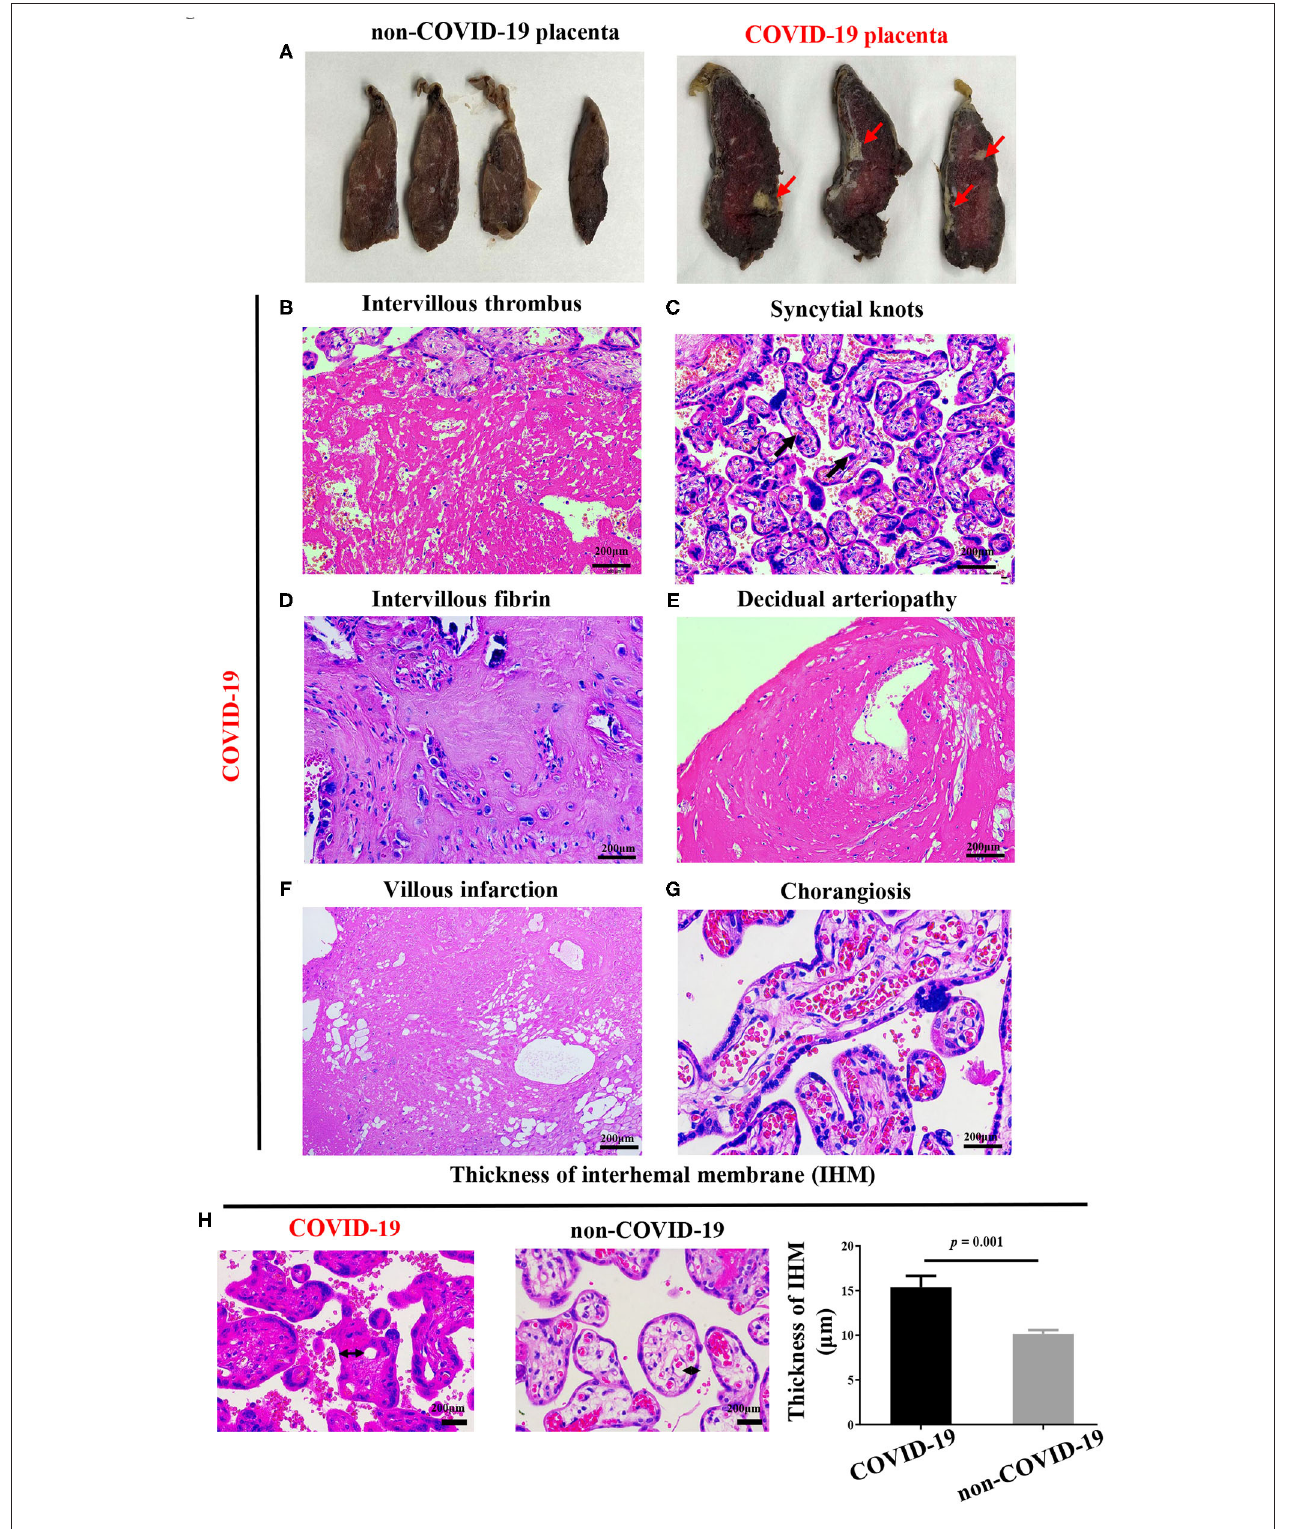
FIGURE 3 | Pathological changes of COVID-19 placentas. (A) Sagittal plane of COVID-19 placentas showing hypoxia and infarction, (B–H) H&E stains of COVID-19 placentas showing (B) intervillous thrombus (C) syncytial knots and (D) intervillous fibrin, (E) decidual arteriopathy, (F) villous infarction, (G) chorangiosis, and (H) increased thickness of IHM, as compared with non-COVID-19 placentas, indicating placental oxygen and nutrient transport capacity are decreased. P- values were derived from the Student’s t- test.